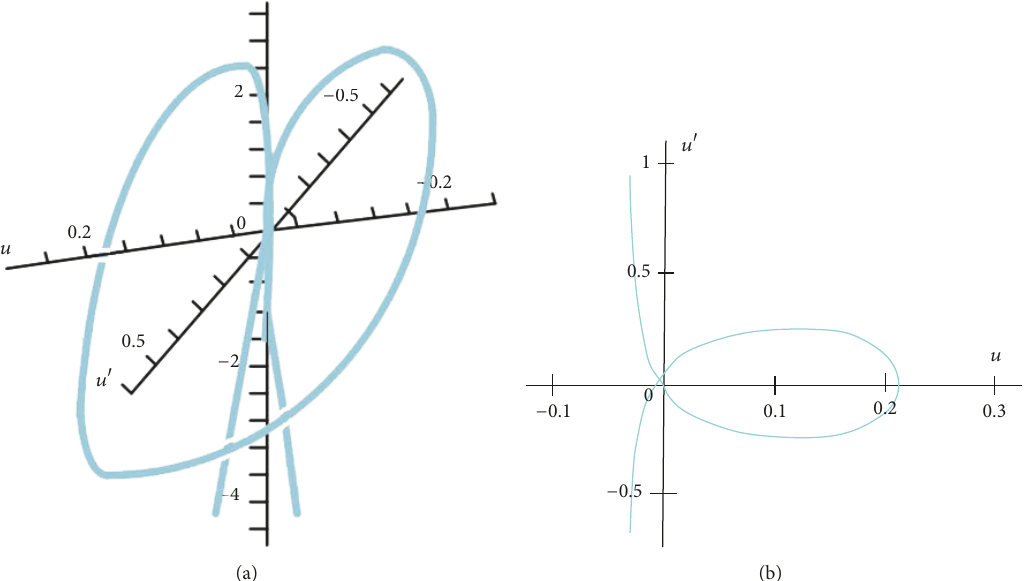
Figure 1: Numerical plot in the phase-space (𝑢,𝑢 𝜂 , 𝑢 𝜂𝜂 ) for the model KdV model (55) or model (48) with no higher order perturbation term, for 𝛾 = 1 (conventional case). As expected in (a), the soliton solution is shown via its related homoclinic orbit to lie on a curved surface. In (b), the projection on the plane (𝑢,𝑢 𝜂 ) .